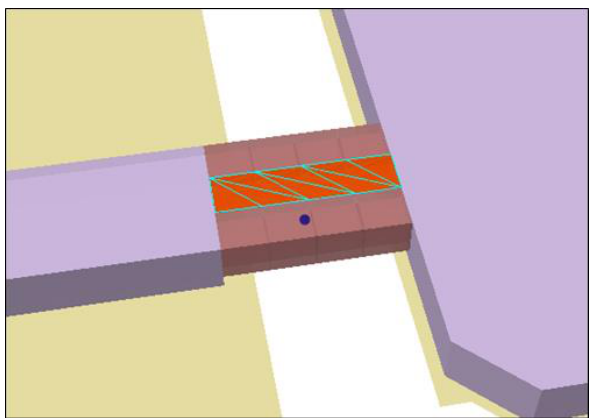
Figure 10. The location of foyer in the bridge (hanging